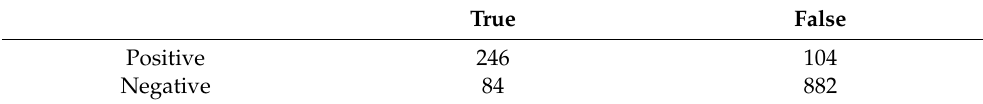
Table 10. Confusion matrix of k-NN classifier applied 10 days before the swarming event. True False